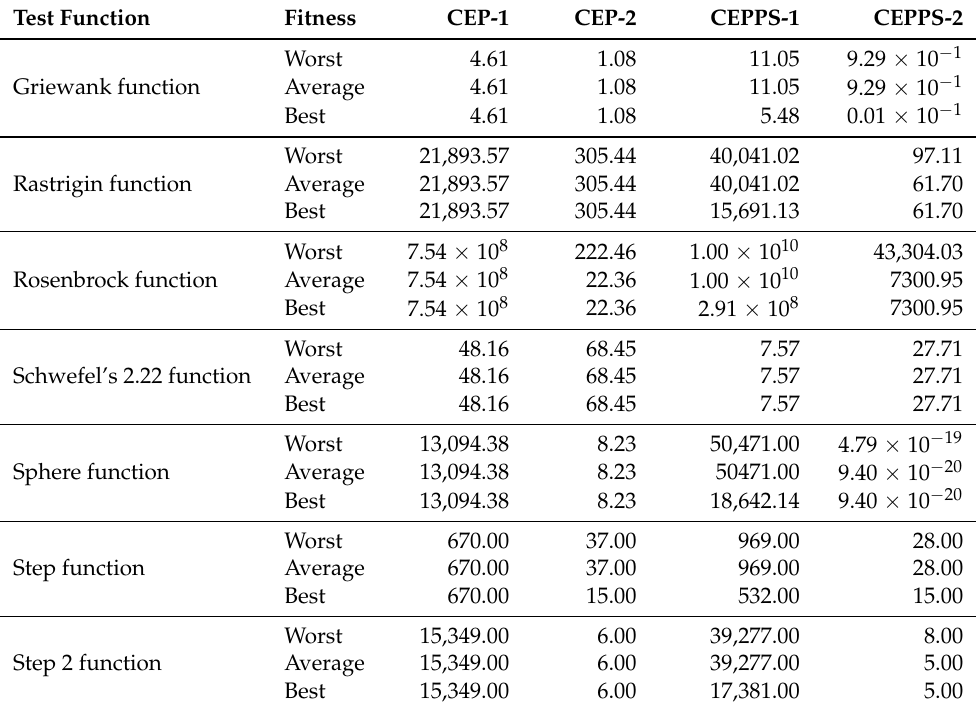
Table 2. Performance analysis of the fitness value of generalized benchmark test functions [29]. Test